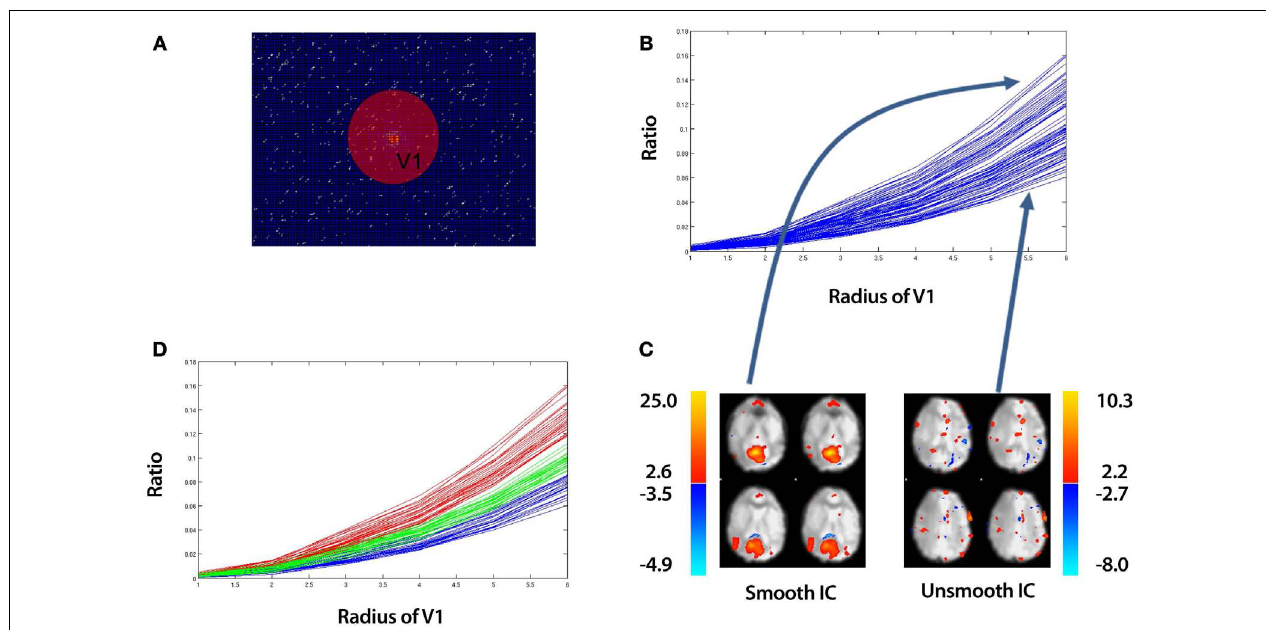
spatial frequency information. (B) A plot of the ratio of low to high frequency information [equation (6)] vs. the radius of sphere V 1 for all ICs. (C) A spatial map of the top and bottom curves corresponding to the smoothest and least smooth IC respectively. (D) Applying k-means clustering to split the ICs into a set of “smooth” (red curves), “subsmooth” (green curves), and “unsmooth” (blue curves) ICs. Each line in (B,D) represents the ratio for a particular IC calculated over all slices, not just the slice shown in (A)